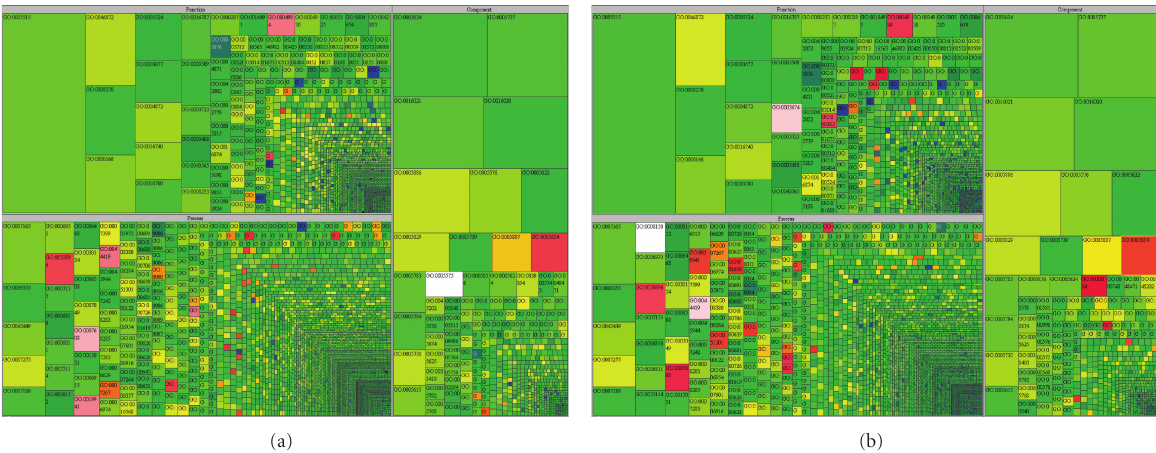
Figure 1: Ontological coverage of (a) the BOM, and (b) SPAM oligonucleotide microarrays. The classes of proteins represented by oligonucleotides were analyzed by comparing the proportion of bovine Gene Ontology (GO) terms connected to the BOM and SPAM targets. All bovine GO terms were extracted from NCBI and are displayed using Treemaps, divided into the three ontologies (biological process, molecular function, and cellular component). The number of bovine genes per GO term is proportional to block size and the ratio of BOM or SPAM representation for each GO term is indicated by color; black = no probes, from white (50-fold lower) to blue (10-fold lower) indicates under-representation, green indicates equal representation, from yellow (10-fold higher) to red ( ≥ 50-fold higher) indicates over-representation. The number of blocks, their size, and their color is a global overview of GO representation.